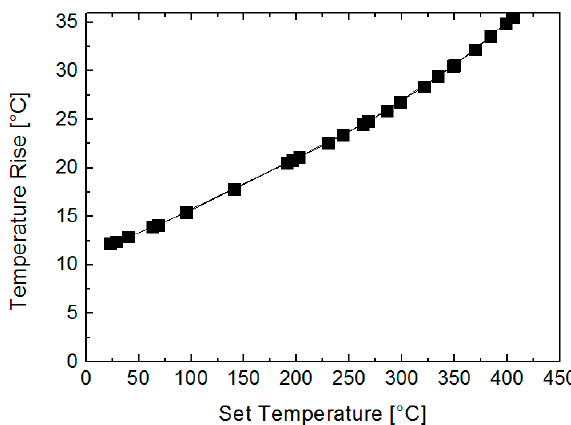
Figure 3. Temperature increase up to 400 °C caused by the laser heating on the surface of polysilicon at different temperatures. The induced temperature rise increases with the ambient temperature dominated by the thermal conductivity, which decreases with temperature.